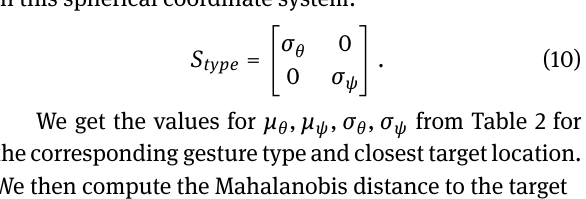
Given this coordinate frame and a potential target point P, we first transform it to the hand frame hand p = T target hand p target